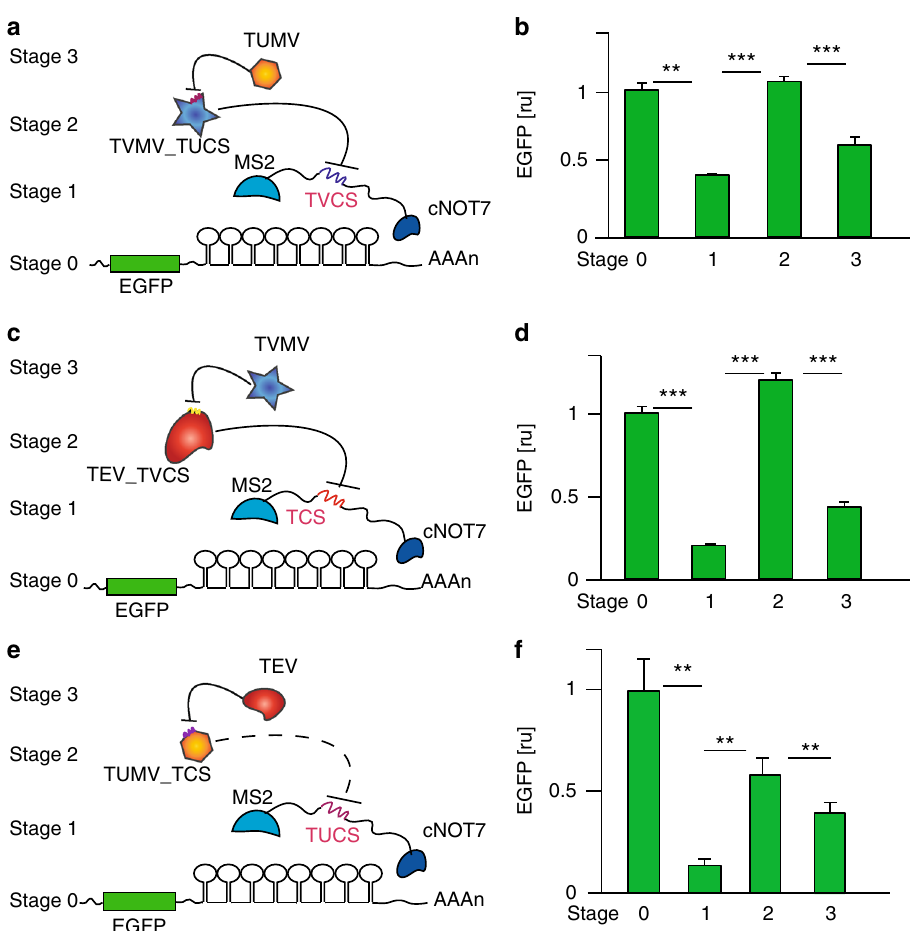
Fig. 4 Protease – protease systems. a , c , e Schematics of the three-stage signaling cascades. EGFP translation is repressed by MS2-CS-cNOT7 (Stage 1), while RBP activity is disrupted by a protease (Stage 2), which is itself engineered to include a cleavage site for an orthogonal protease. When Stage 2 protease activity is inhibited by an upstream protease (Stage 3), MS2-CS-cNOT7 is able to repress target mRNAs. b , d , f Corresponding fl ow cytometry data for the geometric mean and standard deviation of EGFP normalized by transfection marker mKate and rescaled to no repression values. ru relative units. Signi fi cant changes determined by unpaired t -test are indicated with asterisks *** p -value < 0.001, ** p -value < 0.005 n = 3 replicates. Data collected 48 h post